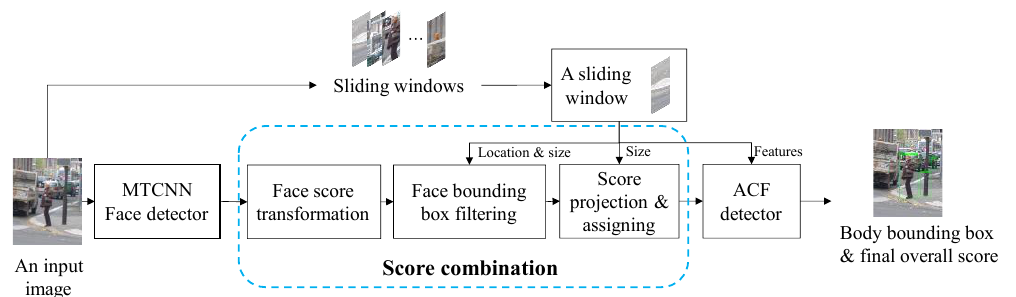
Figure 2. The workflow of the proposed human body detector.